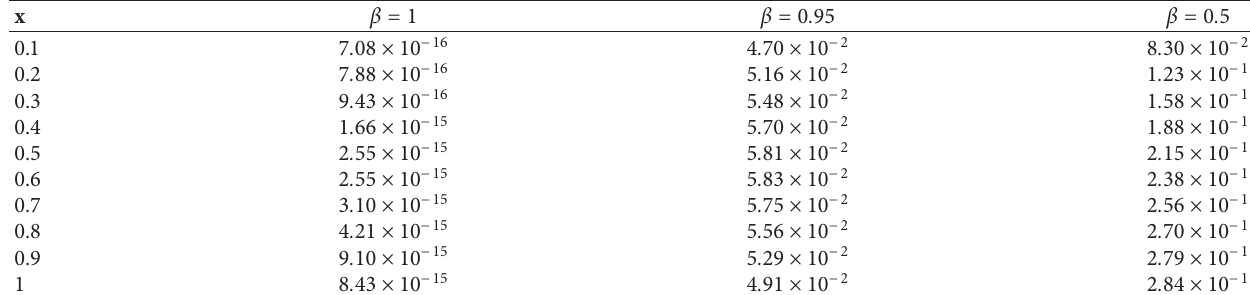
Figure 10: (a) Comparison between the absolute error and error at x � 1 and β � 1 for Problem 4; a good agreement between them is est observed. (b) The error function for β � 1 and various quadrature nodes corresponding to Problem 4. Table 7: The results are obtained for different fractional orders and N �